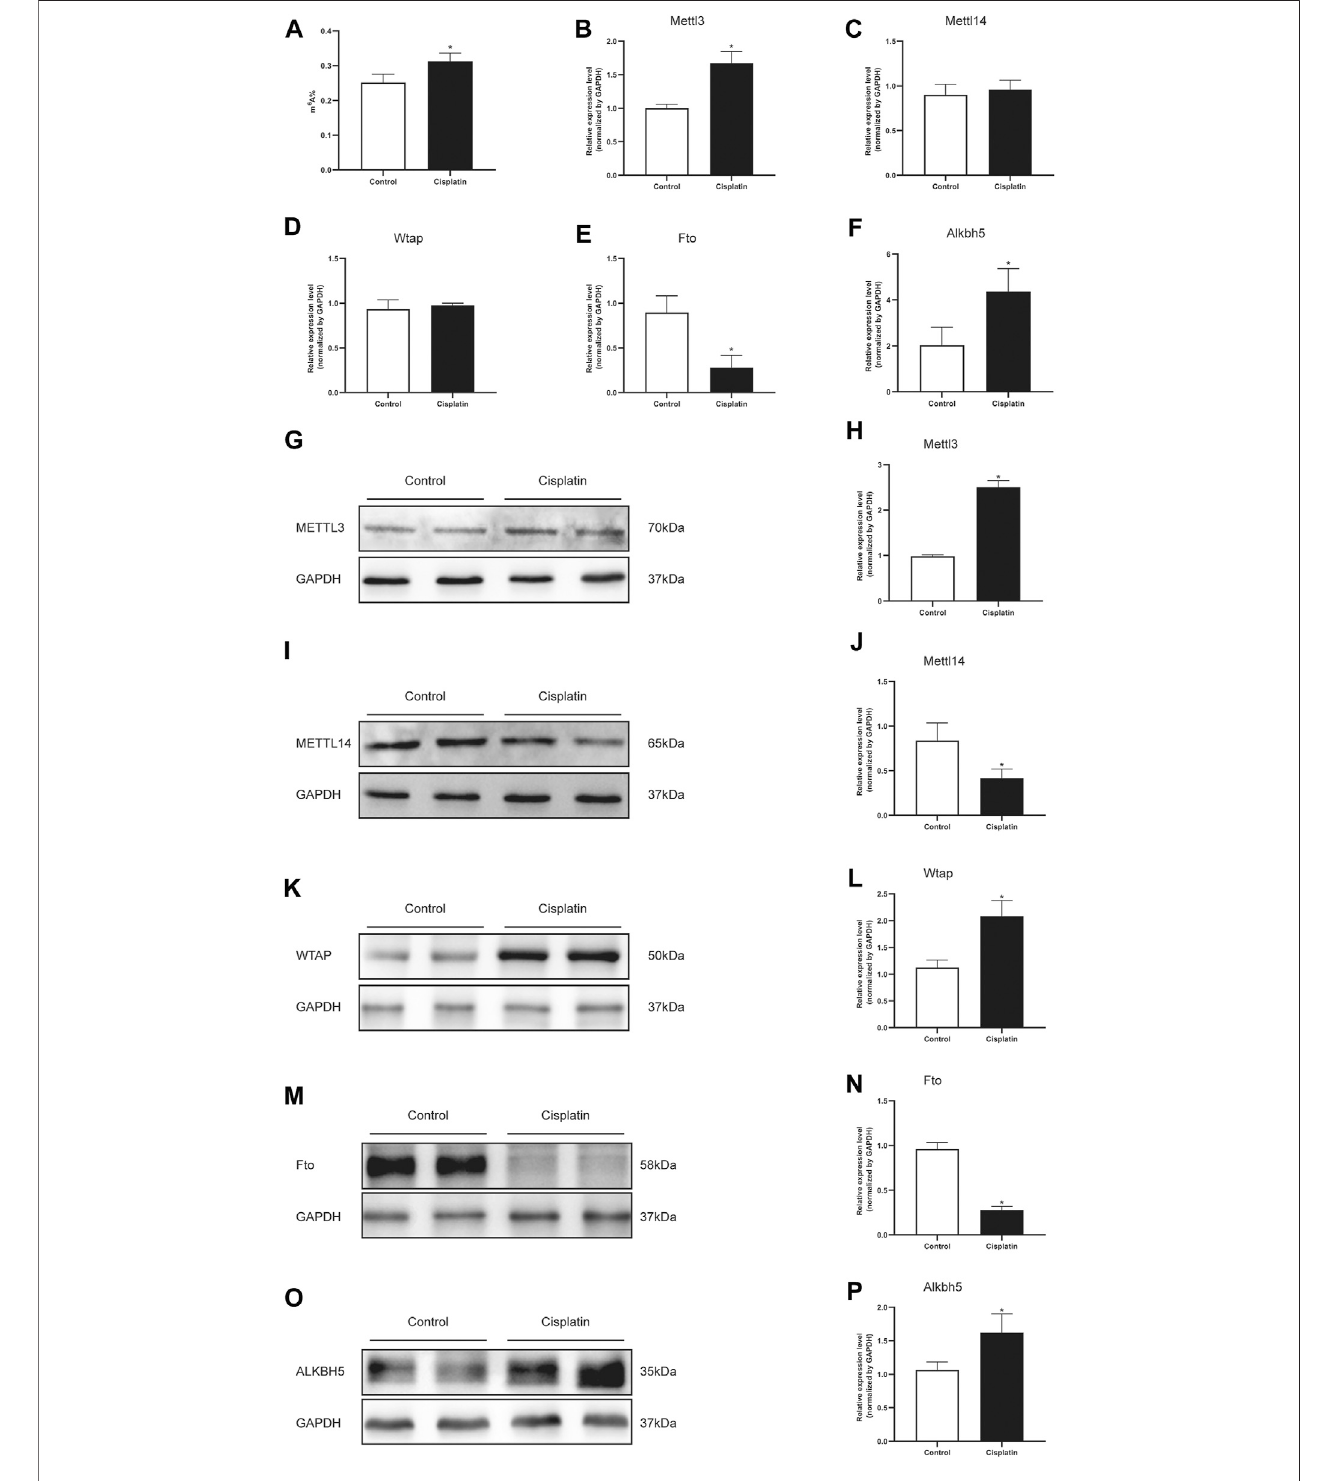
FIGURE 2 | Cisplatin increased the total m 6 A level and modulated the m 6 A-related genes in the mouse kidneys. (A) Quanti fi cation of m 6 A abundance in total RNA isolated from the kidneys of male mice treated with vehicle or cisplatin. The histogram showing the levels of Mettl3 (B) , Mettl14 (C) , Wtap (D) , Fto (E) , and Alkbh5. (F) mRNA expression was quanti fi ed by qPCR analysis. GAPDH was used as a housekeeping gene for normalizing changes in speci fi c gene expressions. * p < 0.05 vs. controlgroup, n (cid:1) 4pergroup.Representativeimmunostainingimagesanddensitometricanalysiswereperformedtoassesstheproteinexpressionofm 6 A-related enzymes: Mettl3 (G and H) , Mettl14 (I and J) , Wtap (K and L) , Fto (M and N) , and Alkbh5 (O and P) in kidneys of Cis-AKI groups compared with control groups. GAPDHwasusedasaninternalcontrol.Datawereexpressedasmean ± SEMandanalyzedusingStudent ’ s t -testtodeterminethedifferencesbetweenthetwogroups. * p < 0.05 vs. control group, n (cid:1) 4 per